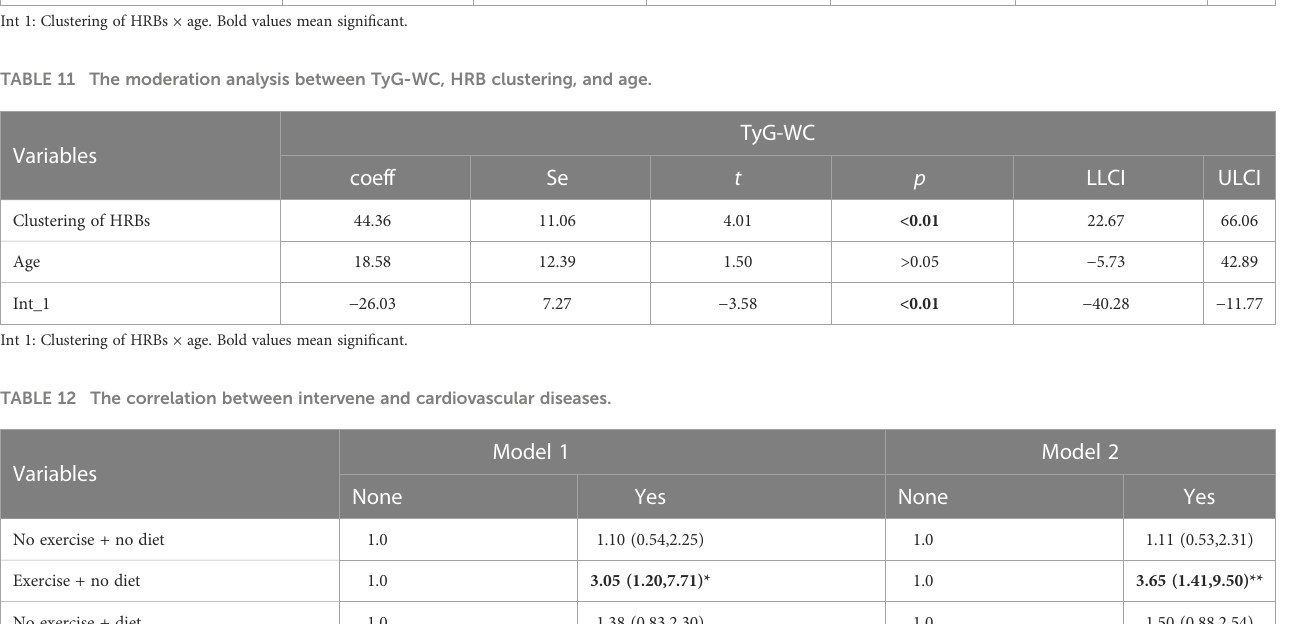
TABLE 11 The moderation analysis between TyG-WC, HRB clustering, and age.